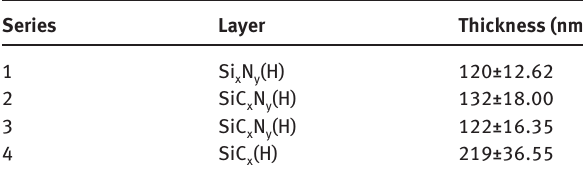
Table 2: Average thickness of deposited layers.